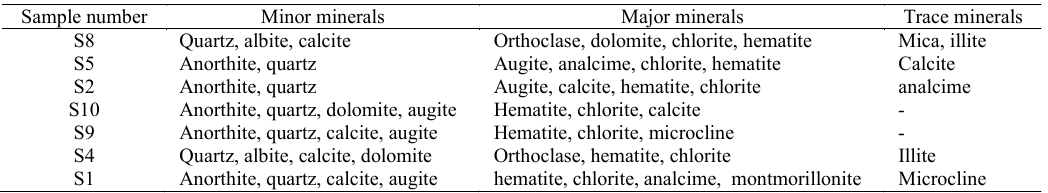
Fig. 3(continue): XRD graphs for some of the samples Table 2: minerals found in the sediment samples of Taleghan Basin (Afshar et al.,